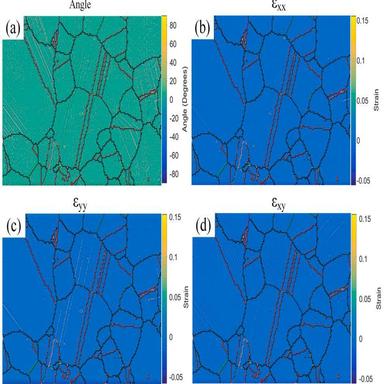
(a) Angles between the strain bands and tensile load direction; (b) ϵxx, (c) ϵyy and (d) ϵxy, distribution in local coordinates after 10,000 loading cycle.